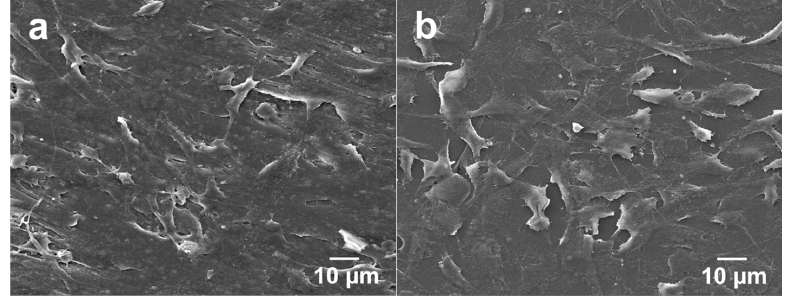
Figure 11. SEM images of PEEK/(15% nHA)-(0.93% MWNT) hybrid cultured with osteoblasts for ( a ) 2 and ( b ) 4 days.